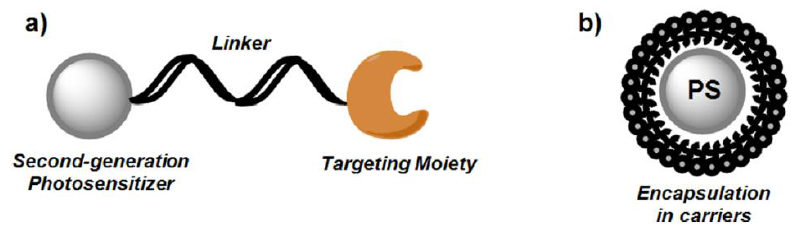
Figure 4. General design of 3rd generation PS: ( a ) conjugation of second-generation PS with tar- geting moiety; ( b ) encapsulation of the second generation into carriers (liposomes, micelles, and nanoparticles). Reproduced with permission from Ivan S. Mfouo-Tynga et al., Photodiagnosis and Photodynamic Therapy; published by Elsevier, 2021